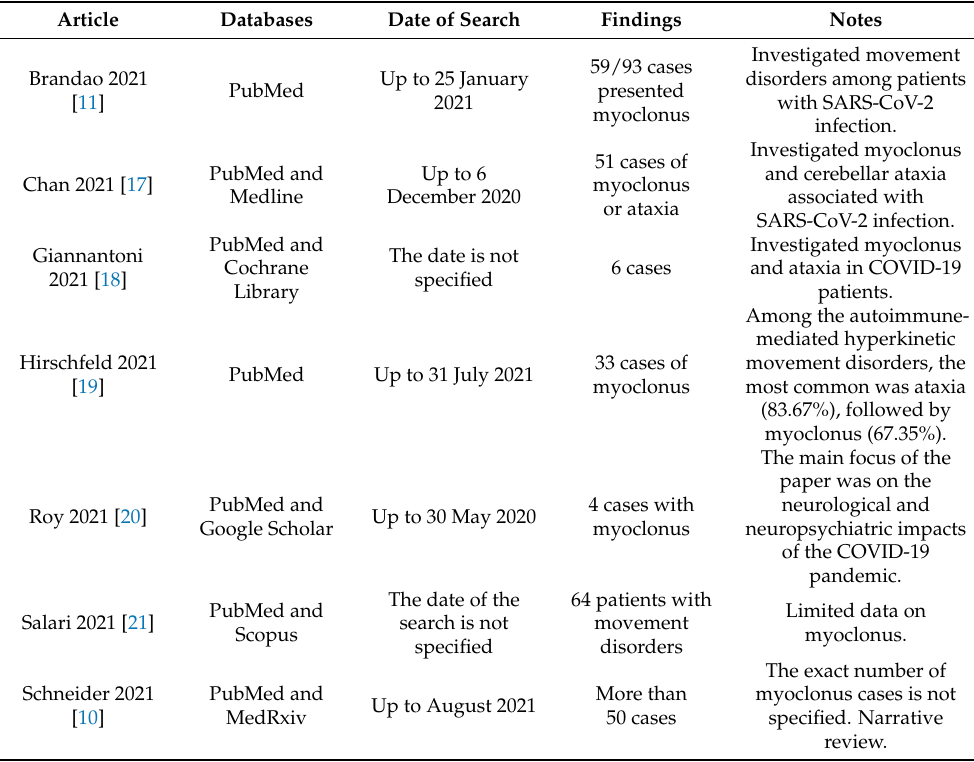
Table 1. Characteristics of the reviews on myoclonus in the context of SARS-CoV-2